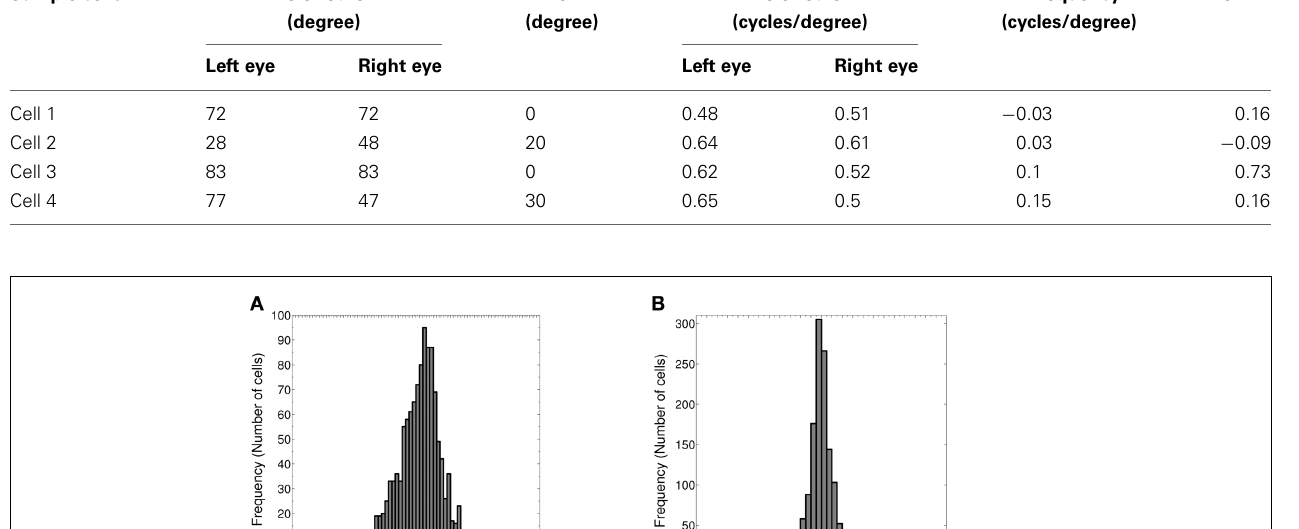
Table 2 | OR and SF preferences in left and right eyes, IDPO, dif-frequency, and OD for four sample cells. Sample cells